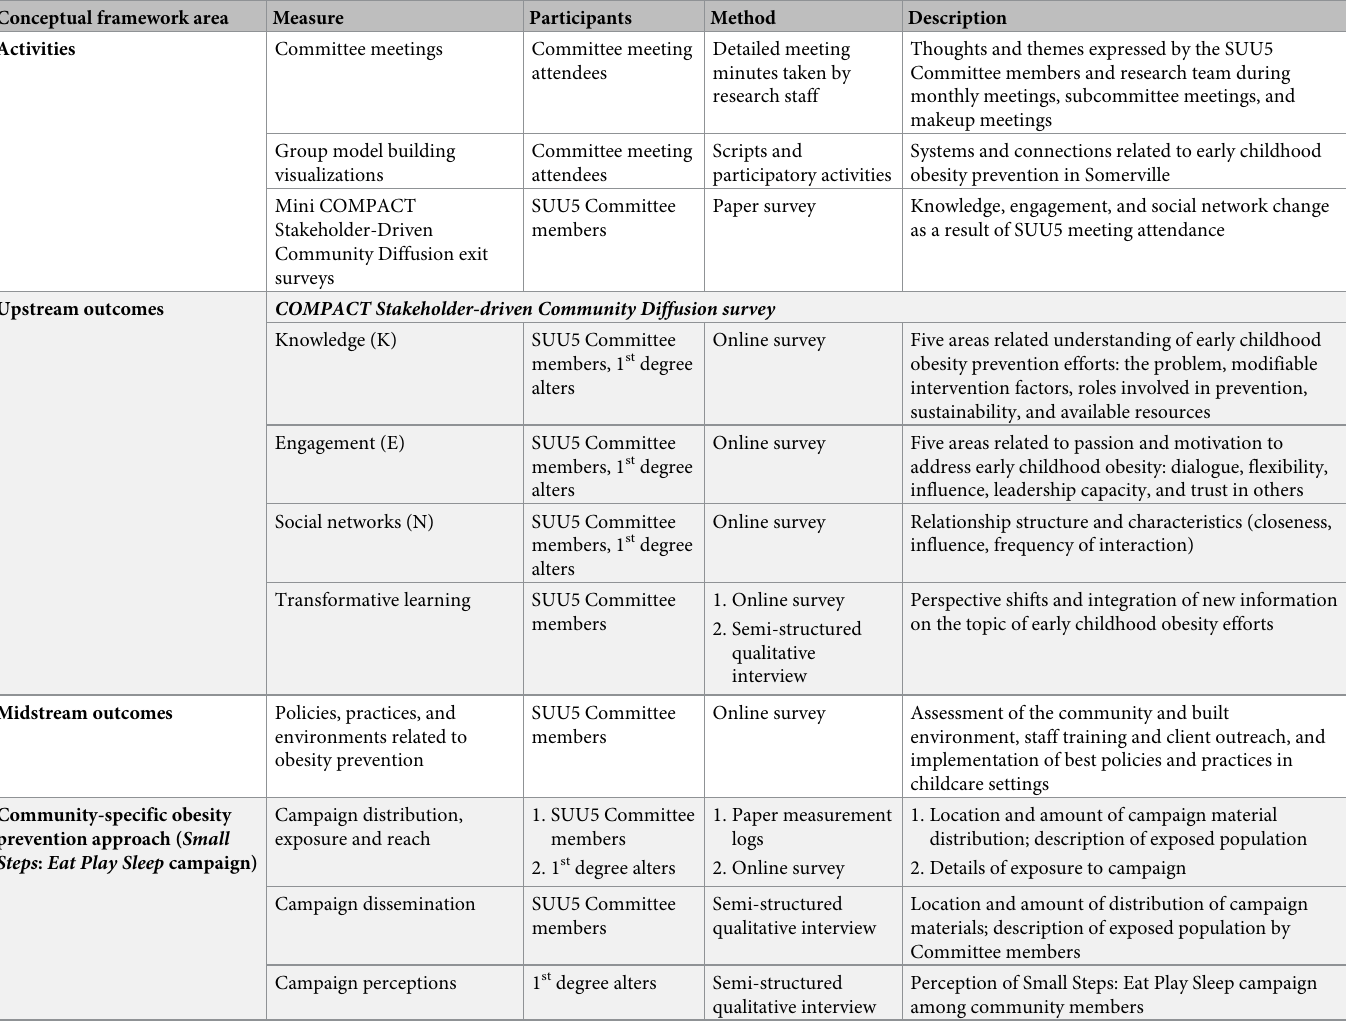
Table 1. Shape Up Under 5 data collection methods and